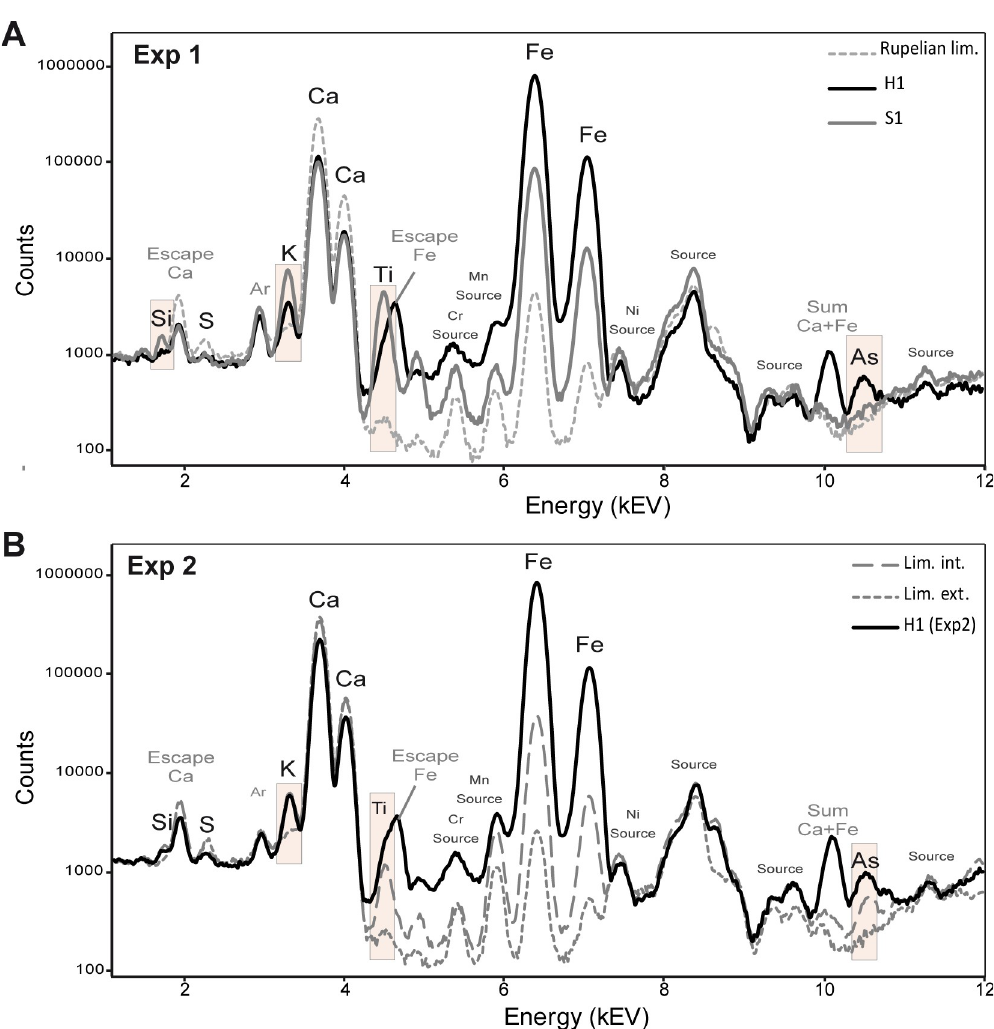
Fig 5. Normalised pXRF spectra of the first experiment (A) and the second experiment (Exp2, B); Normalisation by total counts.